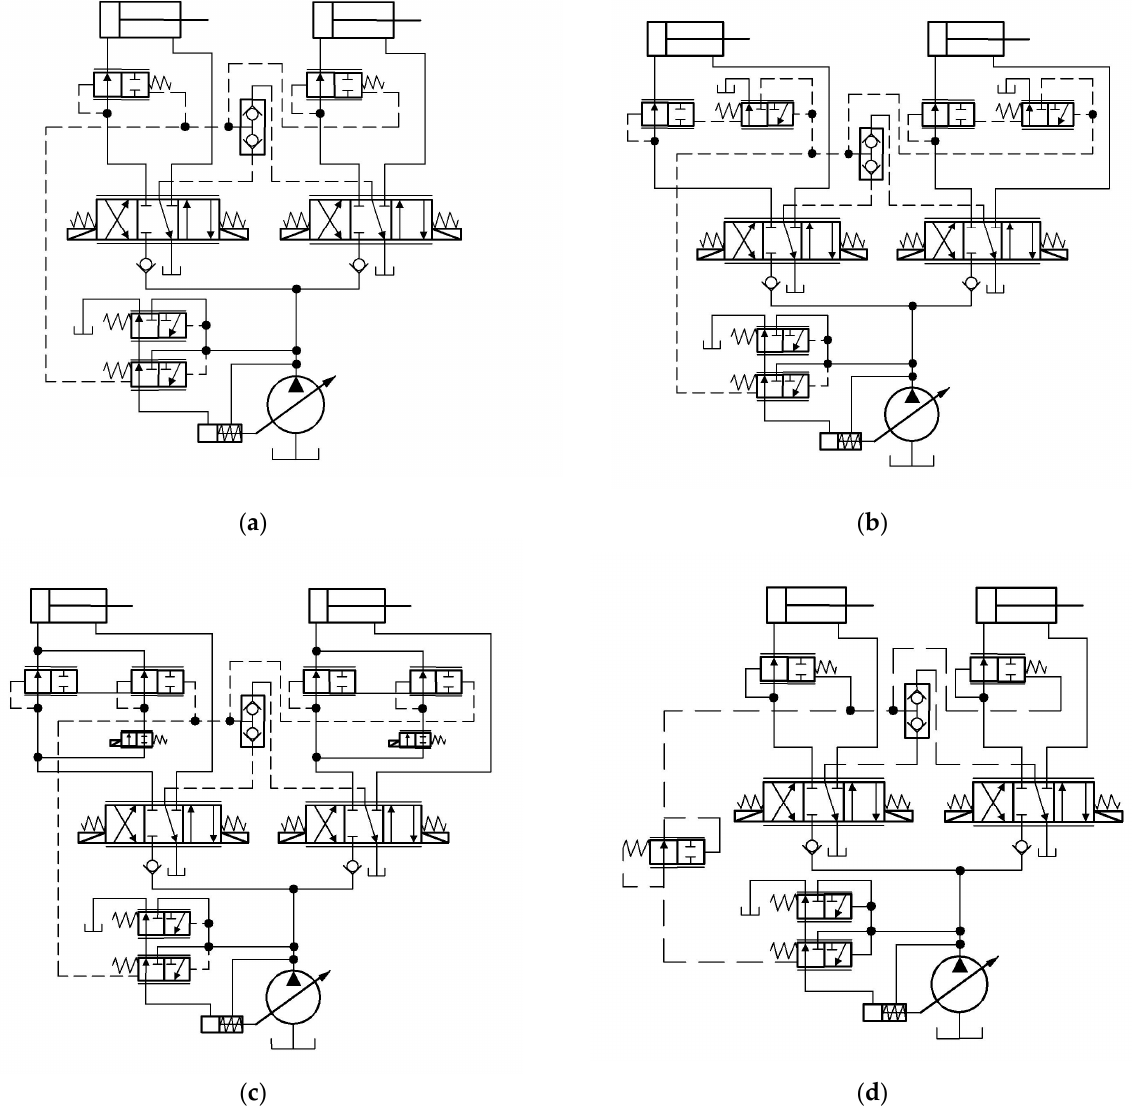
Figure 9. Load-sensitive system figure. ( a ) Structure diagram of traditional load-sensitive system. ( b ) Structural diagram of series hydraulic resistance load-sensitive system. ( c ) Structural diagram of parallel hydraulic resistance load-sensitive system. ( d ) Energy saving control load-sensitive system structure.